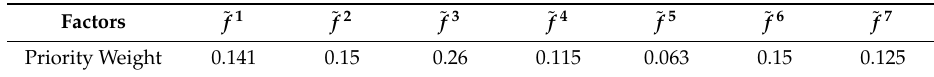
Table 5. The factors’ obtained